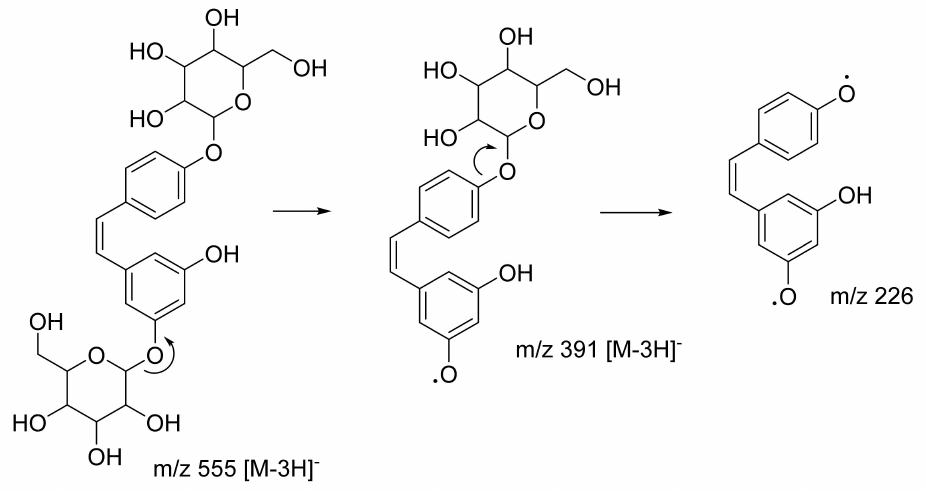
Figure 10. Proposed fragmentation pathway for (Z)-resveratrol 3,4 (cid:48) -diglucoside. References from the mass spectroscopic databases (https://gnps.ucsd.edu/ProteoSAFe/ libraries.jsp, accessed on 6 June 2021, and https://pubchem.ncbi.nlm.nih.gov/,